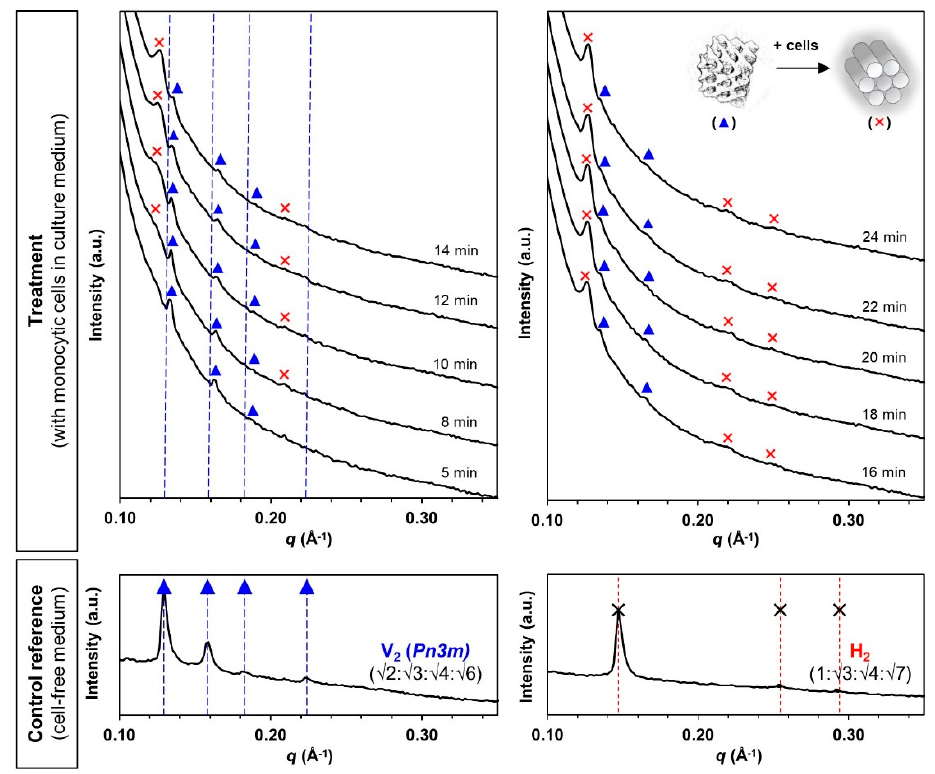
Figure 4. Bio-SAXS profiles of the phytantriol-based cubosomes (V 2 phase) at 1 mg / mL lipid level under circulating flow conditions in the absence and presence of human monocytic cells (27 ◦ C): original V 2 phase ( ▲ , primary q = 0.129 Å -1 ) at a Bragg peak spacing ratio of √ 2: √ 3: √ 4: √ 6 [Miller indices ( hkl ) = (110), (111), (200) and (211)], and evolved H 2 phase ( × , primary q = 0.126 Å − 1 ) at a Bragg peak spacing ratio of 1: √ 3: √ 4 [Miller indices ( hk ) = (10), (11) and (20)]. The mean lattice parameter, a , was deduced from the scattering vector ( q ) and the inter-planar spacing ( d ) of each unit cell according to equation (1) for H 2 phase, and equation (2) for V 2 phase, respectively,